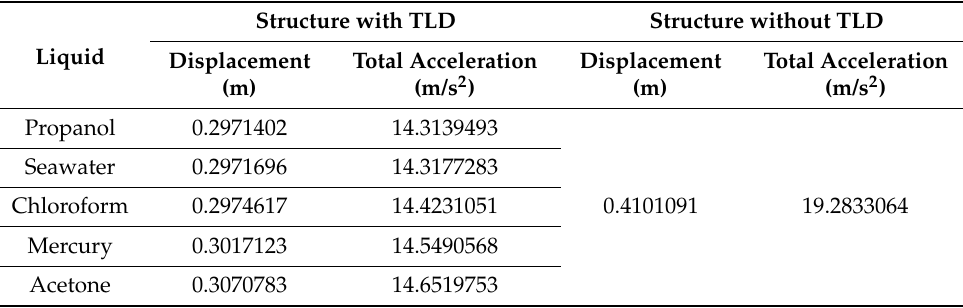
Table 8. TLD + 10-story building model critical earthquake analysis results.